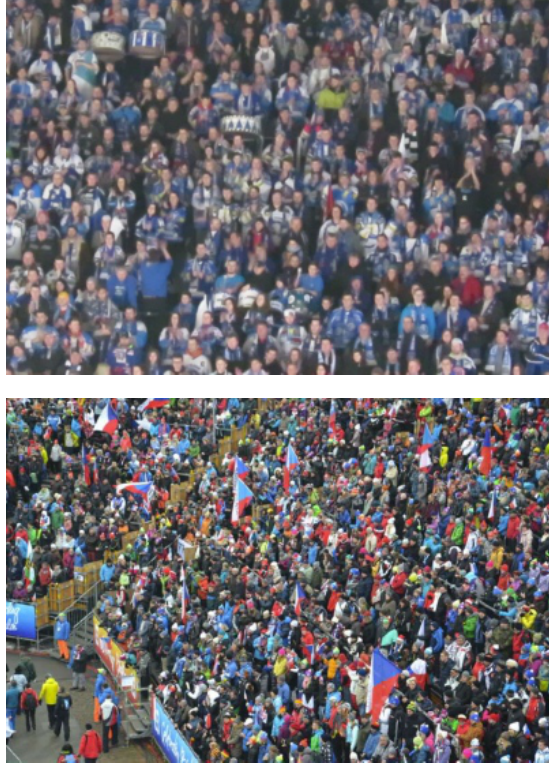
Figure 2. Photo of fans: Ice-hockey stadium – Pilsen (upper) [4], Biathlon stadium – New Town in Moravia (lower) [5].